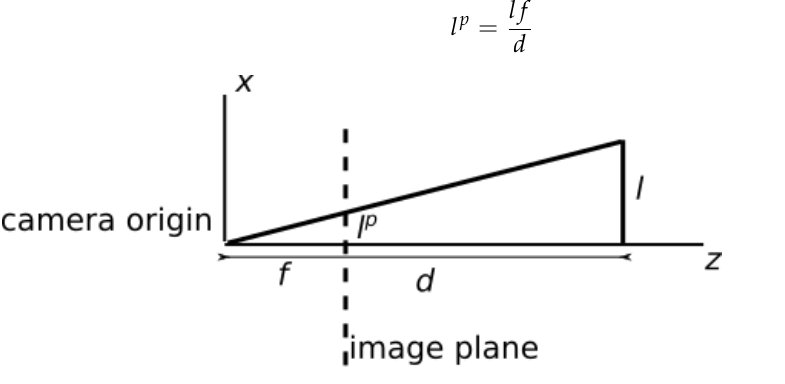
Figure 10. Pinhole camera